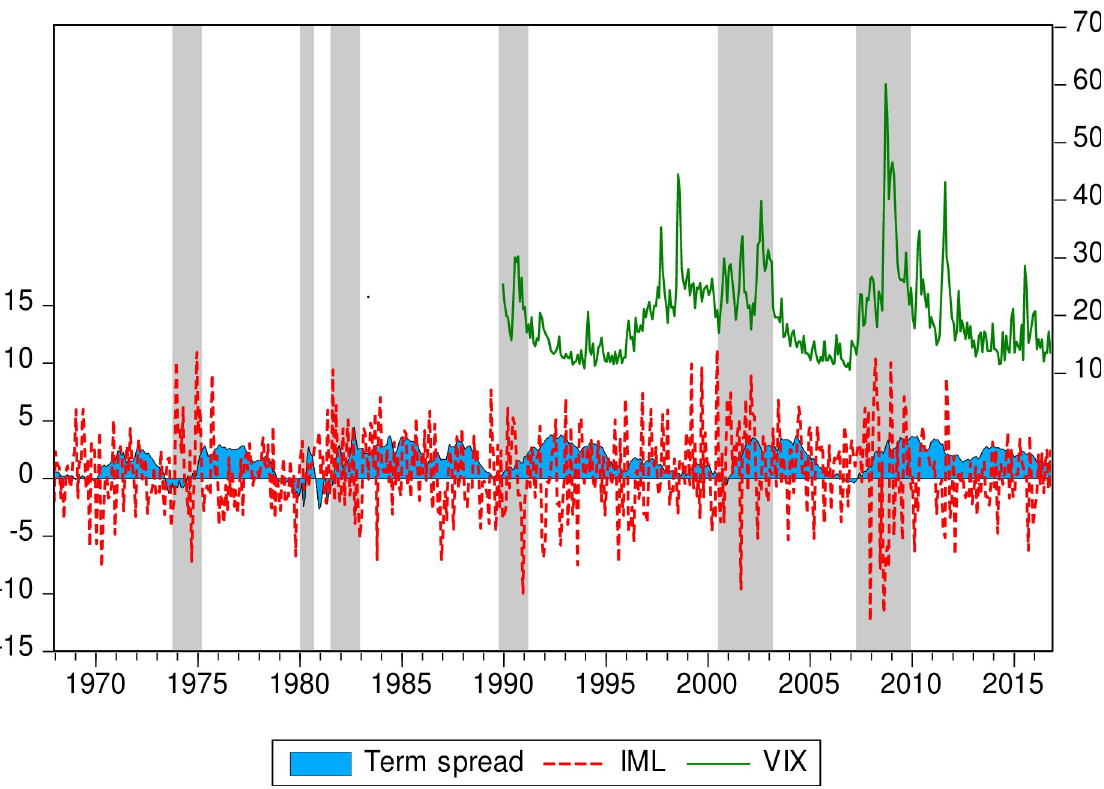
Fig 1. Pa´stor-Stambaugh liquidity, term spread, and VIX. Notes: Shaded areas represent US recessions or crises. IML , a portfolio of illiquid minus liquid stocks, is the Pa´stor-Stambaugh tradable liquidity measure and term spread is the yield spread between 10-year T- bonds and 3-month